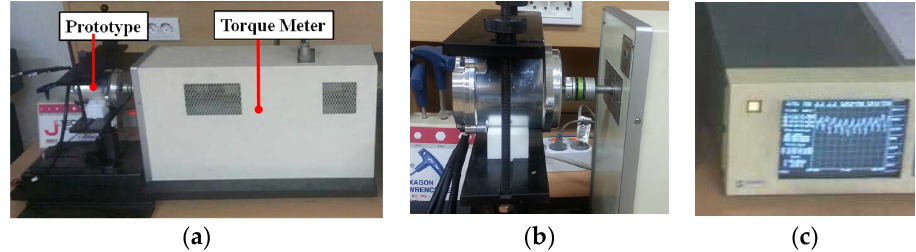
Figure 2. Test equipment for the measurement of cogging torque: ( a ) measurement equipment; ( b ) assembling prototype in measurement equipment; and ( c ) measurement monitor.